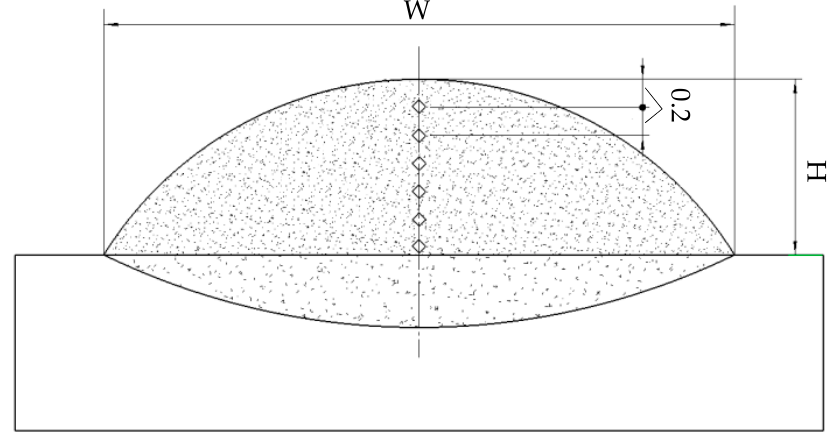
Figure 2. Microhardness measurement points.